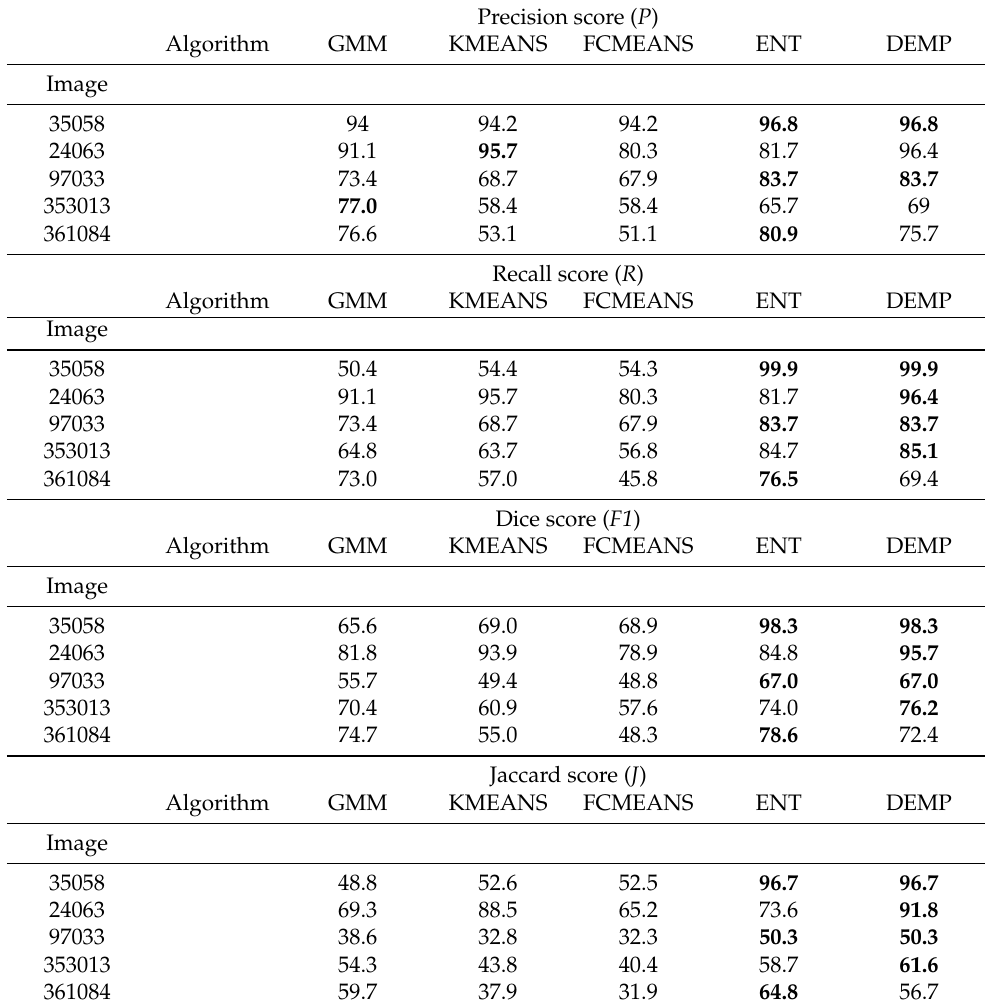
Table 3. Quantitative results of segmentation quality of selected images with different clustering algorithms. The best values are in